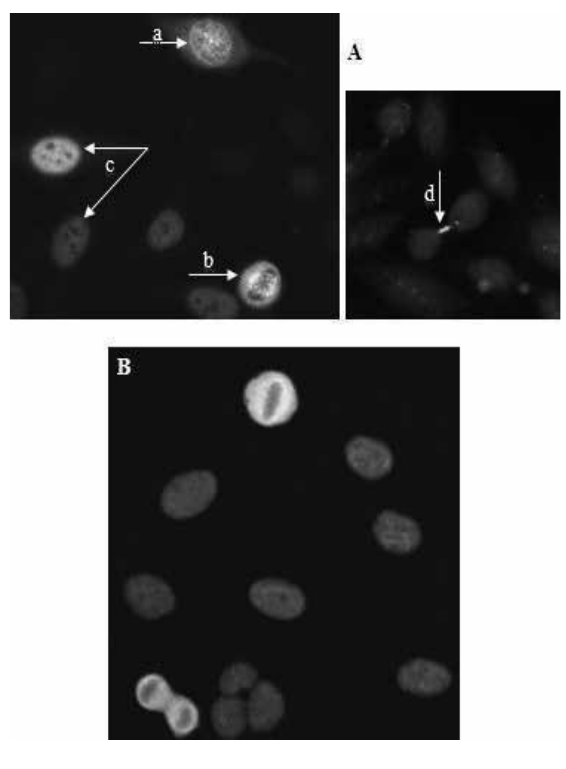
figurE 4 – CENP-F pattern Upper panel: expected and observed pattern on slides A and G; arrow a: cell in prophase expressing centromeres; arrow b: furrowed chromosome plate; arrow c: cell nuclei with subtle difference in fluorescence intensity; arrow d: intercellular bridge. Lower panel: discrepant nuclear fine speckled observed in slides B, C, D, E, F and H. CENP-F: centromeric protein F. To evaluate the reproducibility of cytoplasmic patterns, we used